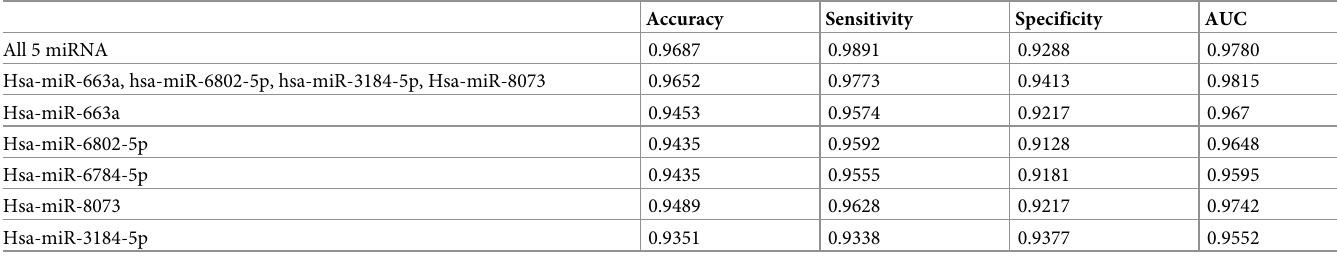
Table 3. Classification statistics of selected